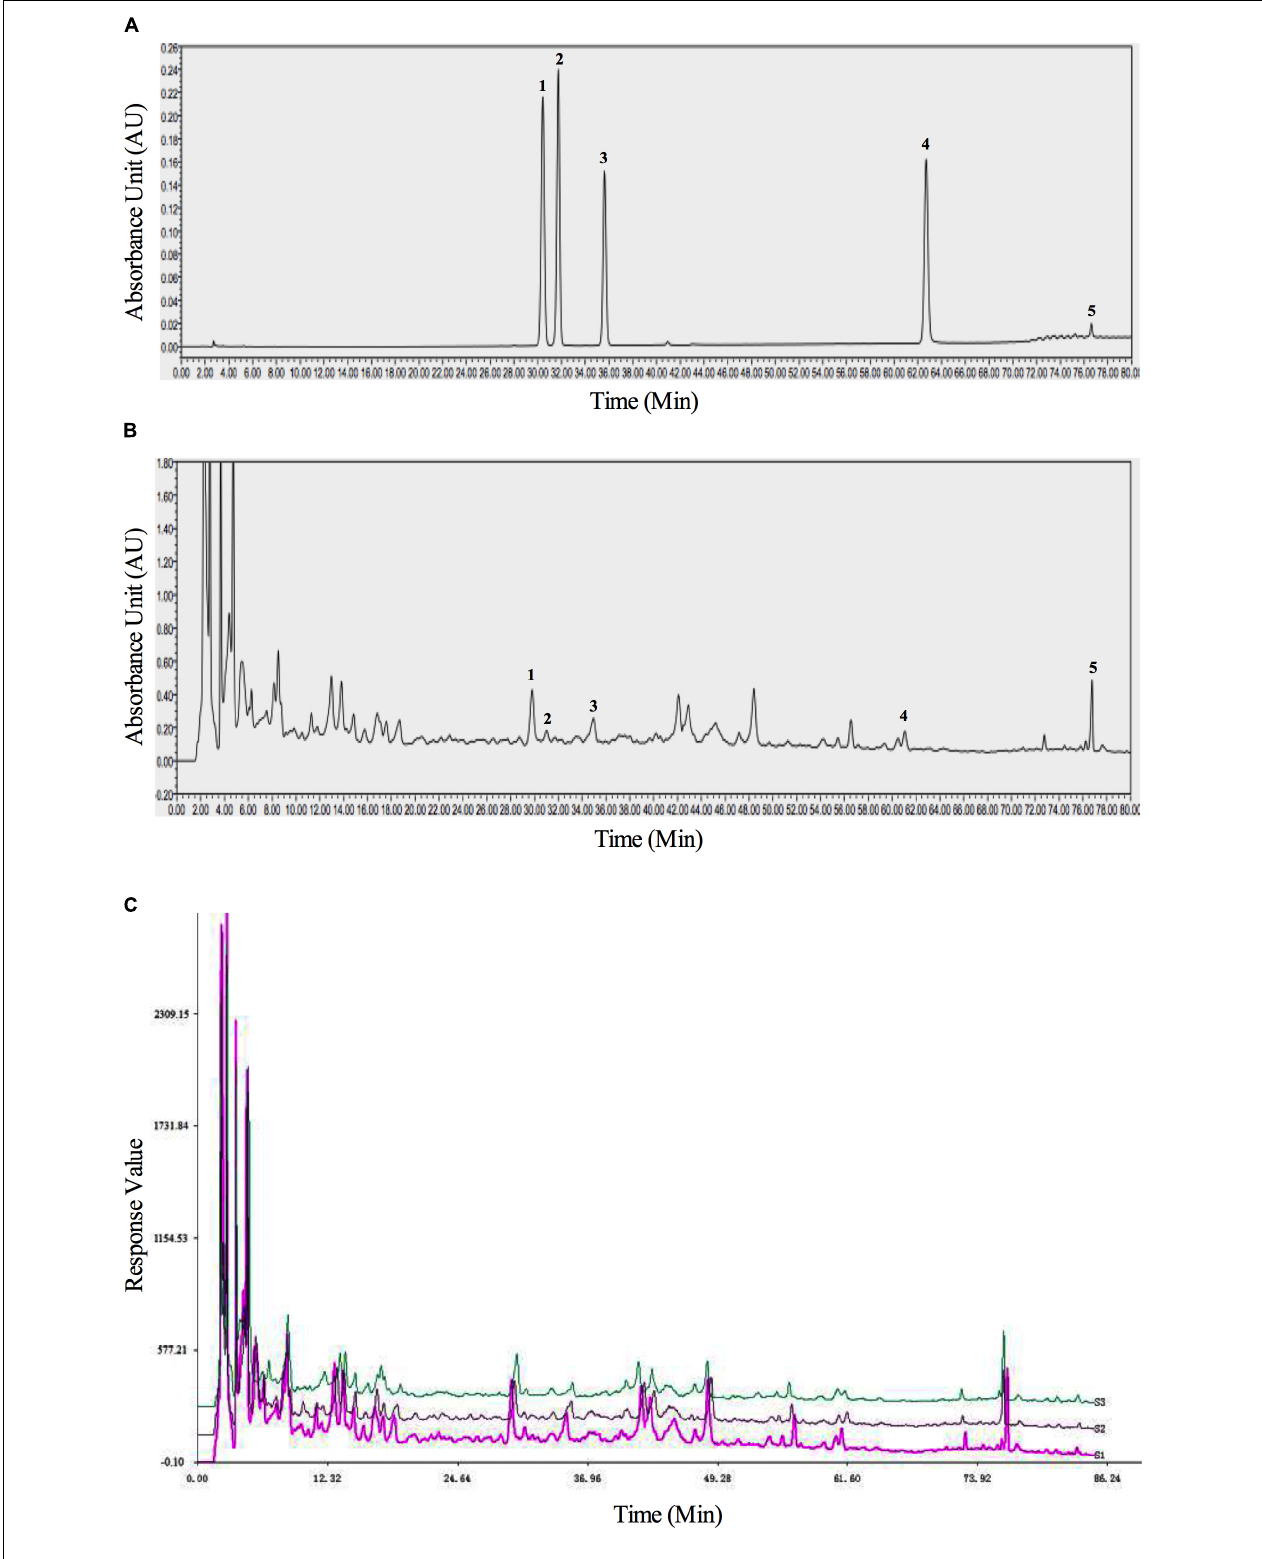
FIGURE 2 | The HPLC fingerprints of reference standards (A) , BSHXR (B) , and BSHXR from three batches (C) . Peak number and identity: 1, ferulic acid; 2, calycosin-7-Glucopyranoside; 3, hyperoside; 4, quercitrin; 5, asperosaponin VI.